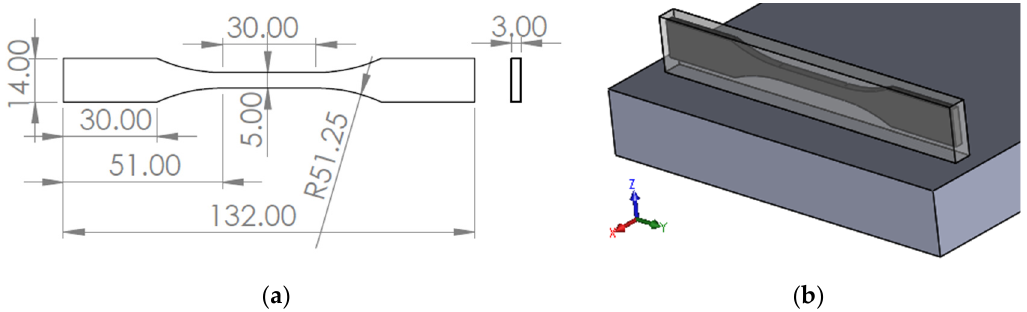
Figure 5. Tensile specimen: ( a ) Dimensions, in mm; ( b ) Build orientation